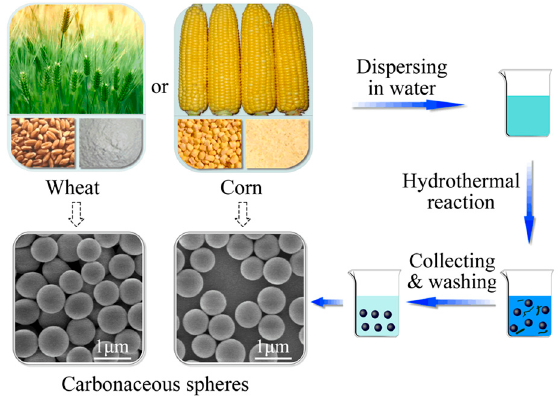
Figure 1. Illustration of the preparation of carbonaceous particles from natural biomass.